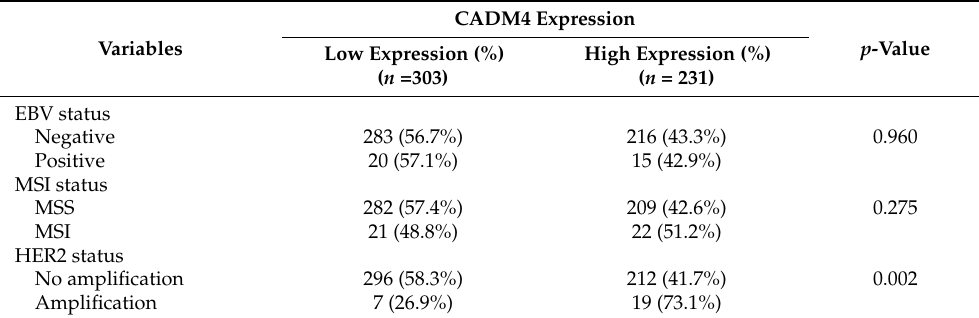
Table 3. Correlations between CADM4 expression and molecular characteristics in patients with gastric adenocarcinoma ( n =